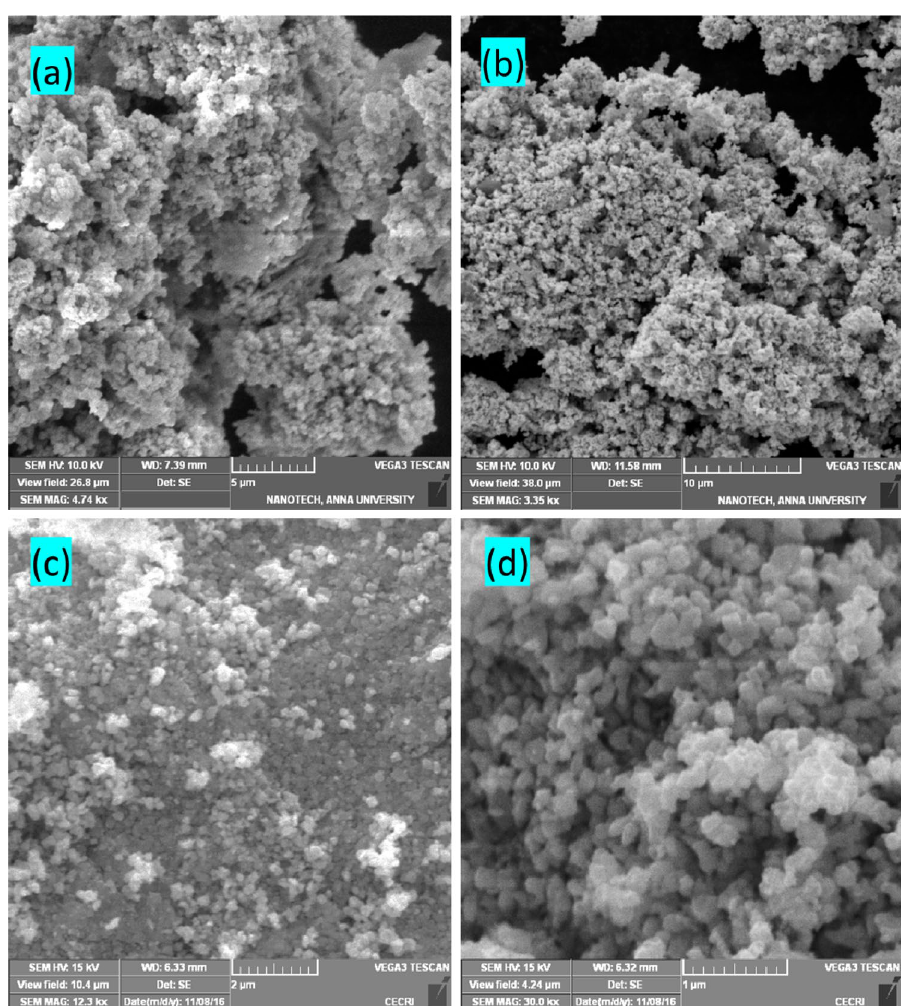
Figure 2. Morphological analysis of ( a , b ) pure CeO 2 and ( c , d ) Ag decorated CeO 2